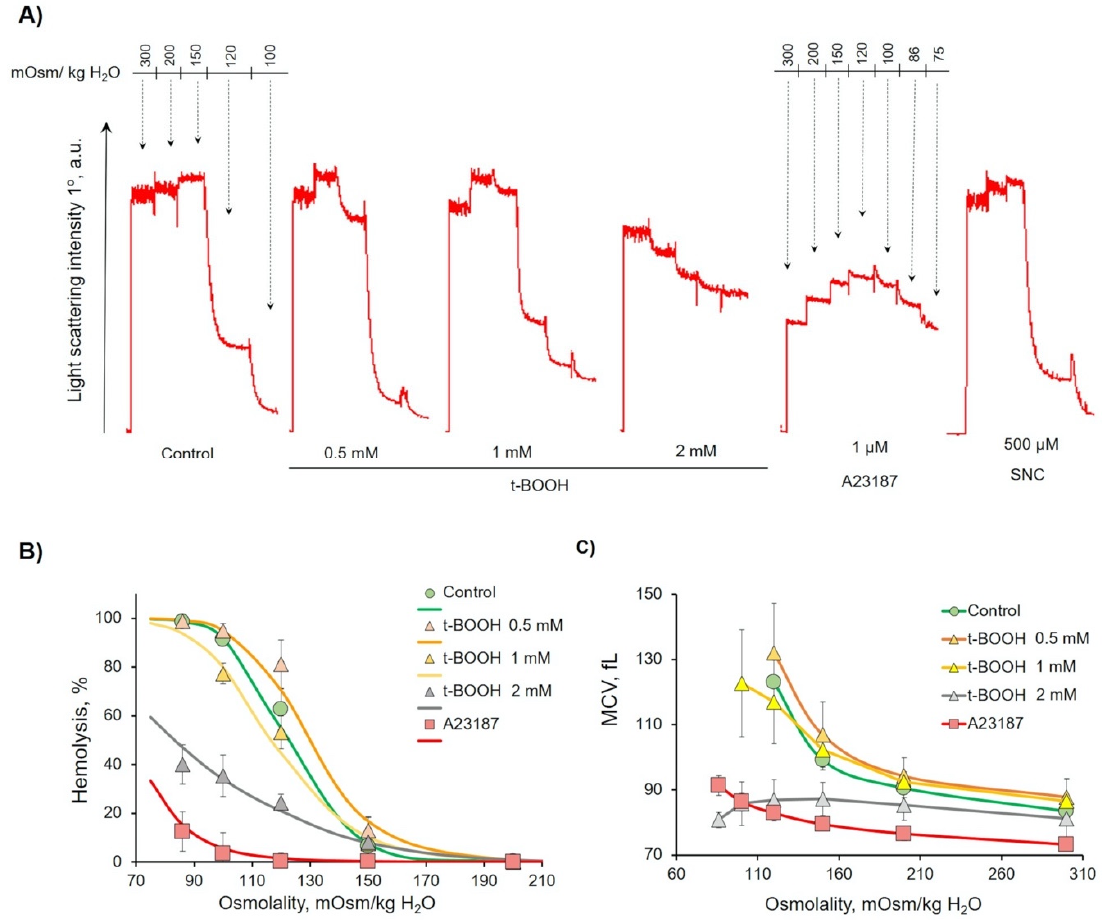
Figure 5. Oxidative stress (OS)-induced decrease in osmotic fragility of RBCs. RBCs (0.5 × 10 9 cells/mL) were incubated with the indicated substances for 1h, and then aliquots (10 µL, 10 6 cells/mL final concentration) of samples were resuspended in HEPES buffer with EGTA to register light scattering intensity corresponding to control. Then, the osmolality was gradually reduced by H 2 O supplementation, from 300 to 70 mOsm/kg H 2 O, to maintain the RBC concentration, and the corresponding number of cells was added at each step of H 2 O supplementation. ( A ) Representative osmotic hemolysis curves from the osmotic fragility test (OFT). ( B ) Quantification of percentage of hemolysis from osmotic fragility test calculated from six independent experiments. ( C ) Quantification of MCV during osmotic fragility test calculated from six independent